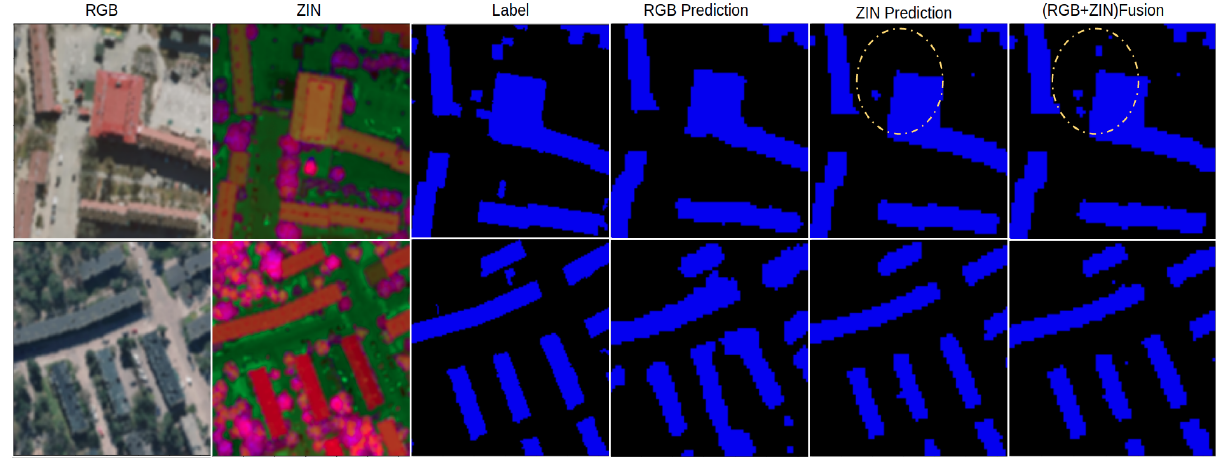
Figure 5. Segmentation Result Samples. From left to right, we have RGB image, ZIN 3-channel representation, ground truth, prediction from the Single Stream Segmentation Network on RGB input, prediction from the Single Stream Segmentation Network on ZIN input and prediction from the Dual Stream Fusion Segmentation